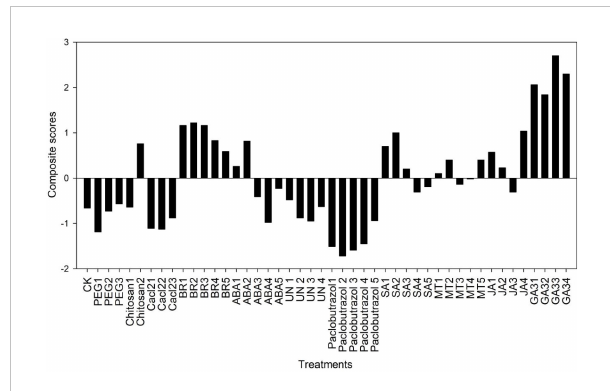
FIGURE 8 Composite scores of principal component analysis for different rice seed priming treatments at low